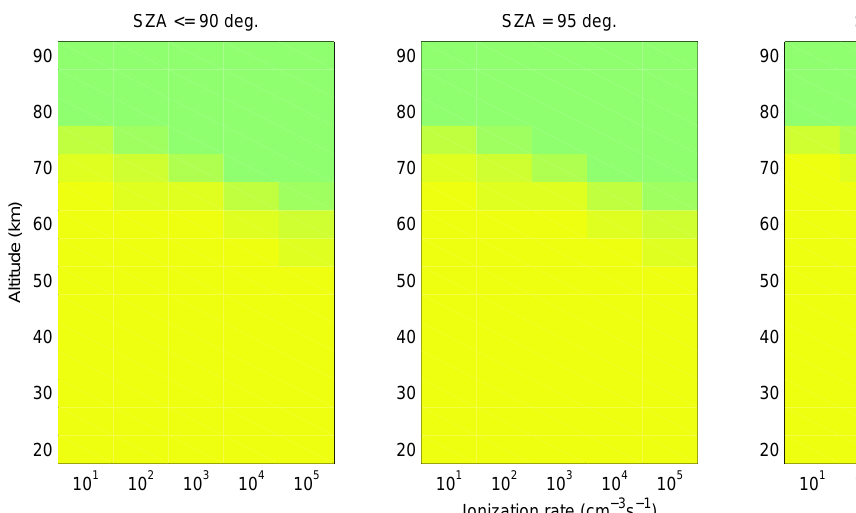
/Q for October 2